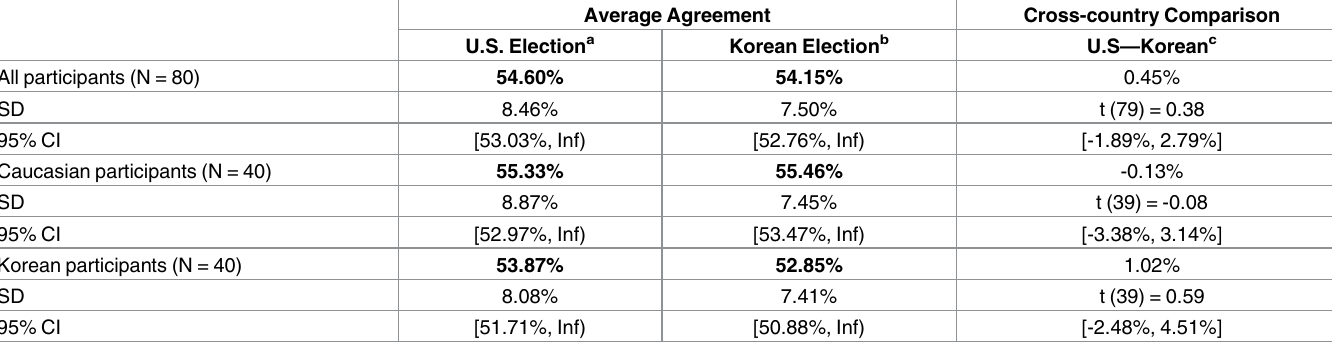
Table 2. Associations between real election outcomes and face-based inferences of competence.